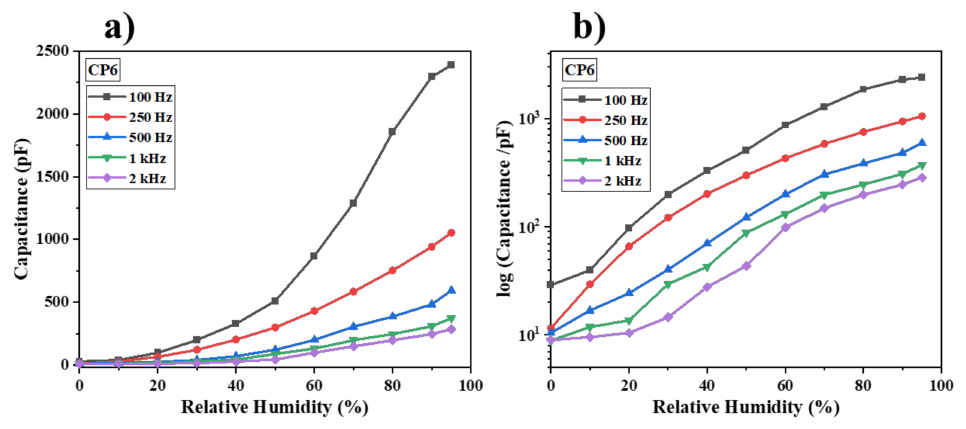
Figure 3. ( a ) Capacitance-humidity and ( b ) log capacitance-humidity relationship of the CP6 -based sensor at different